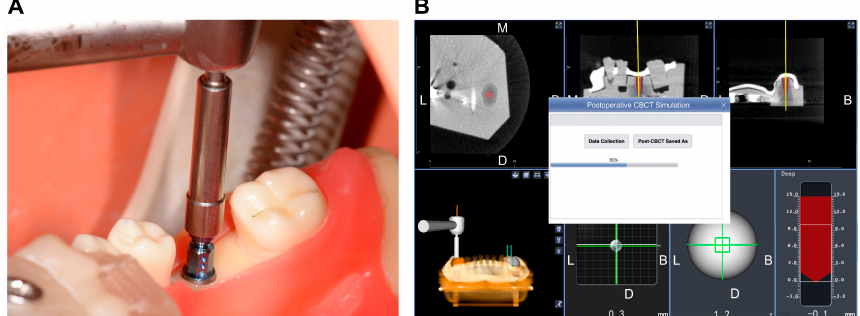
Figure 5. The process of collecting the three-dimensional positions of the inserted implants. The implant headpiece and implant carrier were used to collect the location information of the inserted implant ( A ); interface of the specially designed software that collected the information of the inserted implant ( B ).